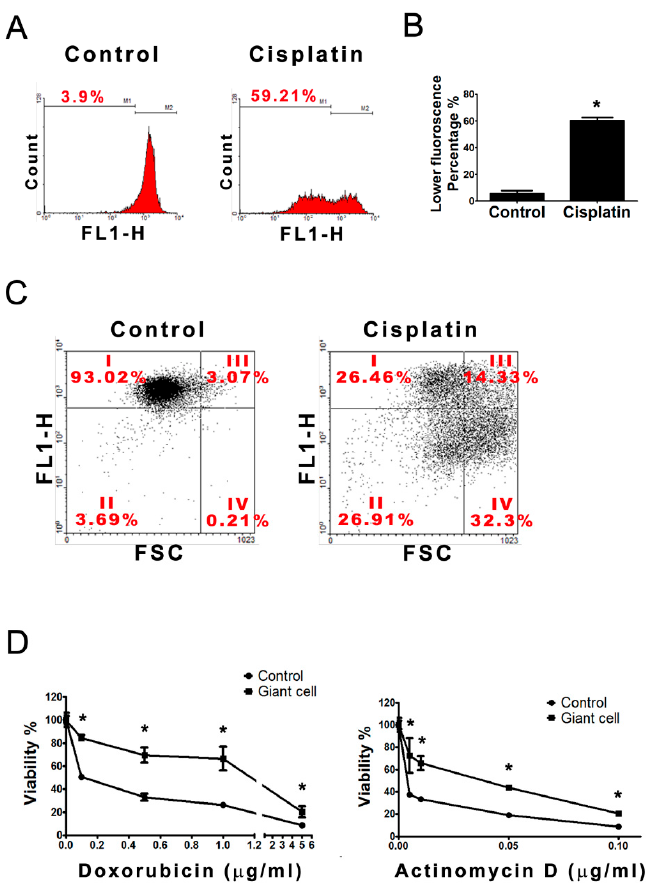
Figure 6. Cisplatin-induced giant cells exhibited chemoresistant properties. ( A ) After the formation of giant cells was induced through 48 h treatment with cisplatin, the chemoresistant activities were subsequently analyzed by multidrug resistance assays. The percentages represent the population with lower accumulation of calcein AM (FL1-H). ( B ) The data in the statistical bar chart are the flow cytometry results, and the less-fluorescent population represents the cells with a lower accumulation of the drug. * p < 0.01, compared with the control group. ( C ) The flow cytometric dot plots were further gated by the cell size (FSC) and the intensity of the calcein AM fluorescence (FL1-H). The region I represents the percentage of non-enlarged cells with higher accumulation of calcein AM; The region II represents the percentage of non-enlarged cells with lower accumulation of calcein AM; The region III represents the percentage of enlarged cells with higher accumulation of calcein AM; The region IV represents the percentage of enlarged cells with lower accumulation of calcein AM ( D ) The cellular susceptibilities of doxorubicin and actinomycin D were detected by crystal violet viability test in control cells and giant cells. The viability percentage of the untreated cells was considered to be 100%. * p < 0.01, compared with the control group at the same